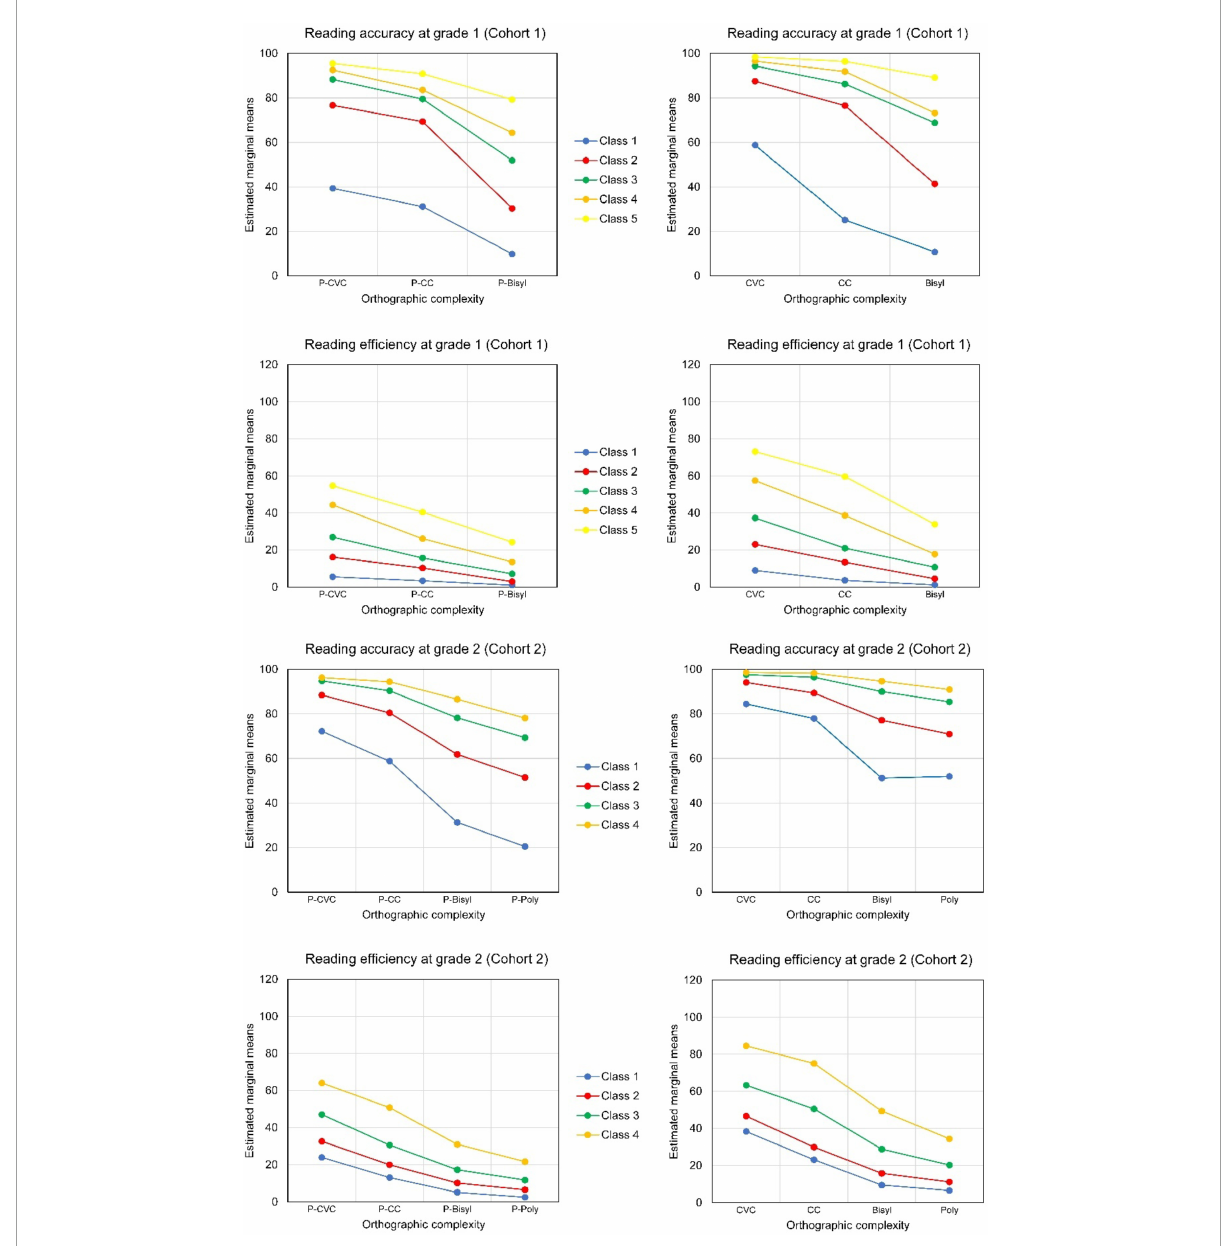
FIGURE5 Average profiles of Reading Accuracy (% correct) and Efficiency (number of words per minute) for Latent Classes in Cohort 1 and Cohort 2; pseudowords to the left, real words to the